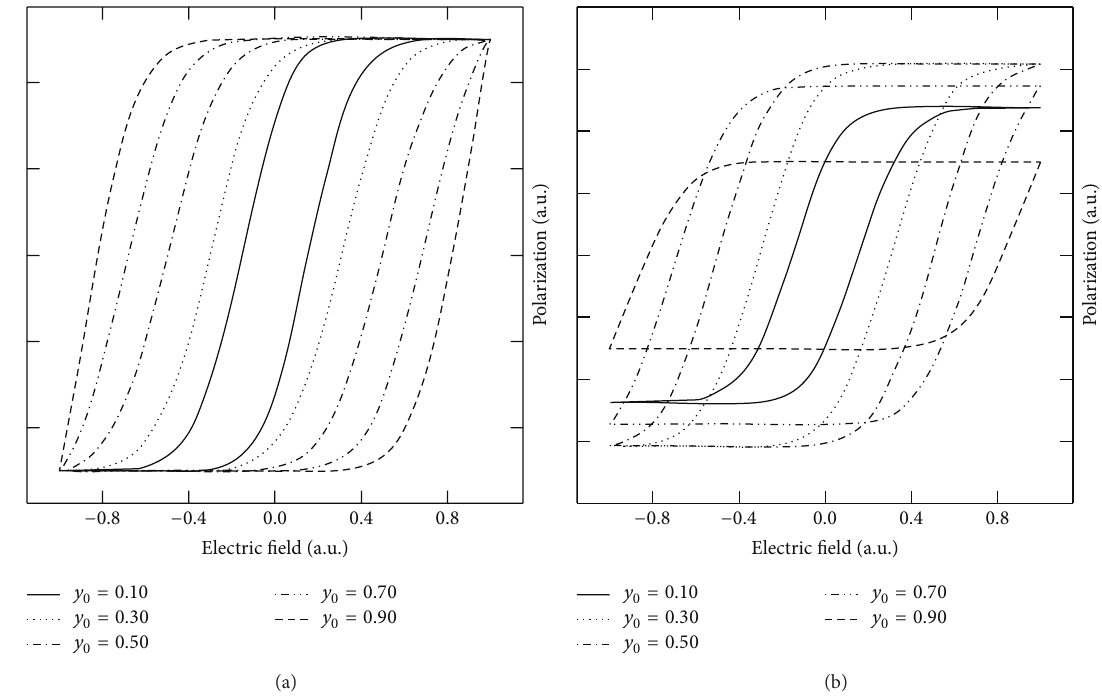
Figure 6: Hysteresis loops obtained from (a) normalized Preisach densities and (b) unnormalized Preisach densities for 𝑦 0 = 0.10 – 0.90 .